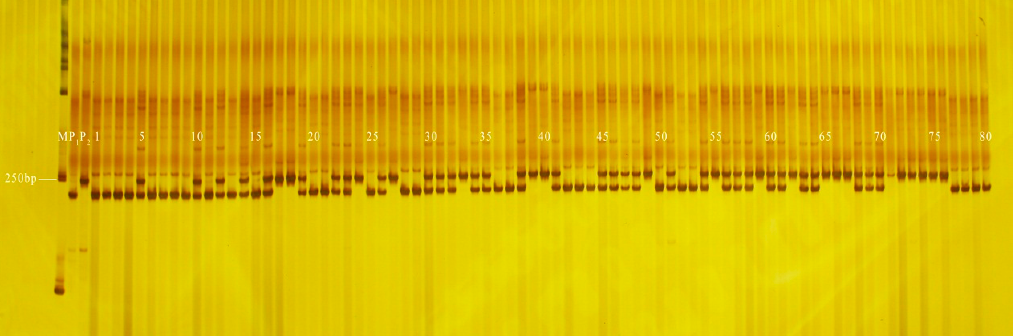
Figure 8. Amplification results of PS13 in some plants isolated from F 5 populations. M: DL2000 DNA Marker; P 1 : GF-7-1-1 (green peel); P 2 : YSB-1-1-2 (white peel); 1–80: F 5 : plants. Table 3. Coincidence rate of GX8, GX9, PS12, and PS13 in F 2 (96 plants) and F 5 (440 plants). Coincidence Rate of F 2 (96 Coincidence Rate of F 5 (440 InDel Markers plants) (%) plants) (%) GX8 85.42